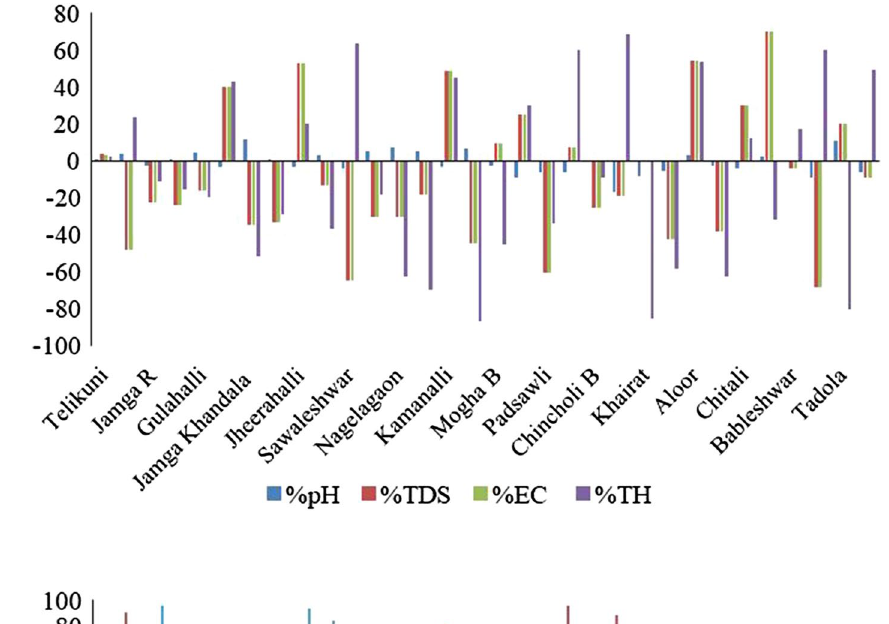
Fig. 42 Relationship between the maximum rainfall and posi- tive ions of both the seasons